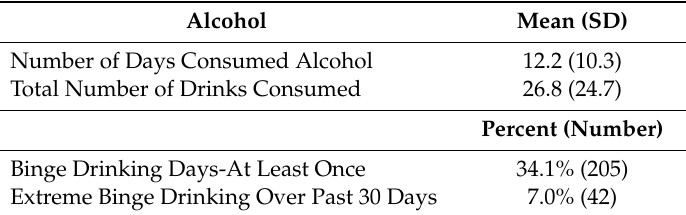
Table 2. Alcohol Consumption and Frequency over Past 30 Days, 2020 ( n =